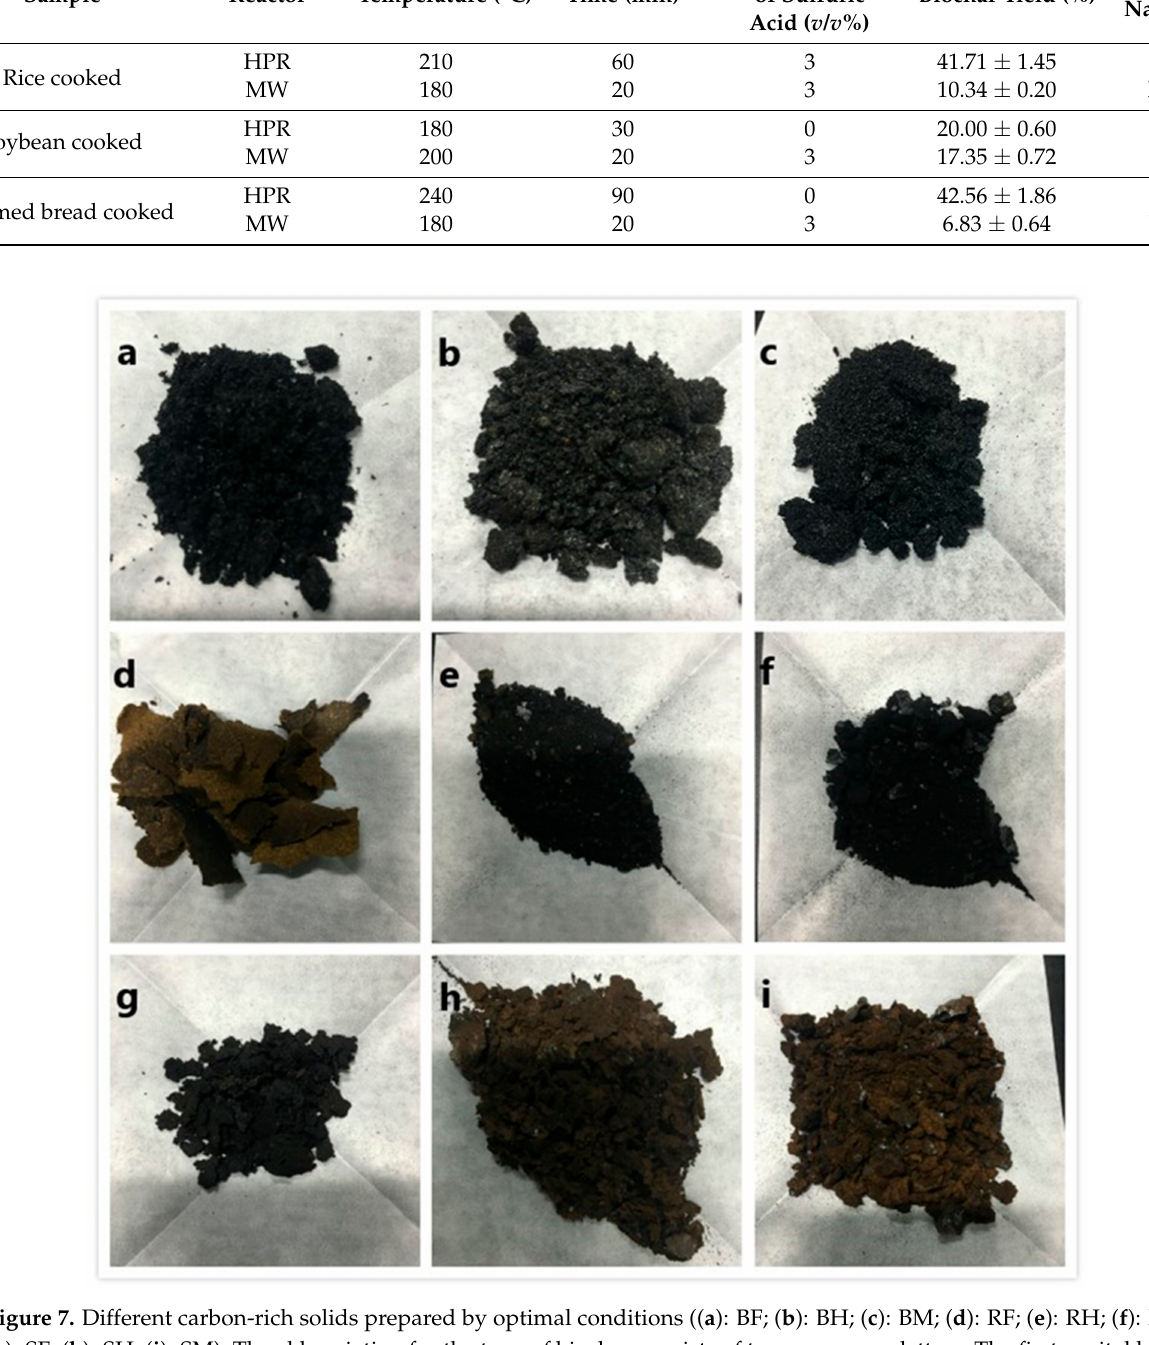
Figure 7. Different carbon-rich solids prepared by optimal conditions (( a ): BF; ( b ): BH; ( c ): BM; ( d ): RF; ( e ): RH; ( f ): RM; ( g ): SF; ( h ): SH; ( i ): SM). The abbreviation for the type of biochar consists of two uppercase letters. The first capital letter represents the FW material for the preparation of biochar (S: cooked soybean; B: cooked steamed bread; R: cooked rice). The second capital letter represents the reactor for the preparation of bi-ochar (M: microwave; H: high pressure reactor; F: tube furnace). For example, RH represents the biochar produced from cooked rice in a high-pressure reactor after using the above experimental